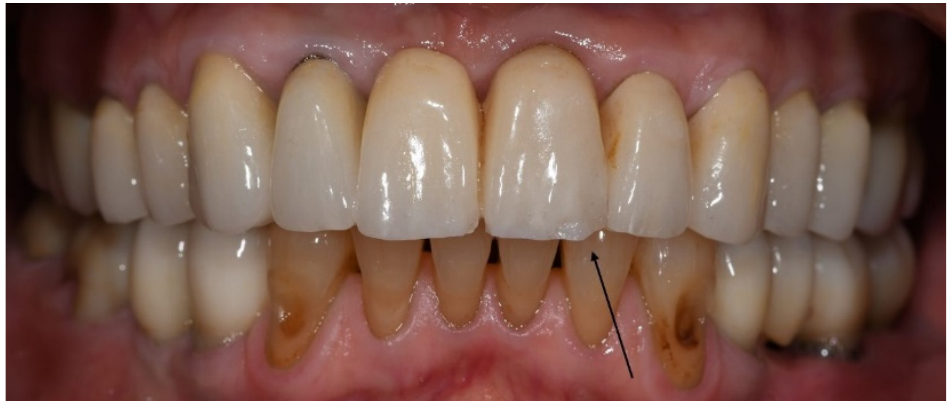
Figure 2. Porcelain chipping on the incisal edge of the veneered monolithic restoration in the upper left central incisor, three years post-cementation. Repair required only polishing .